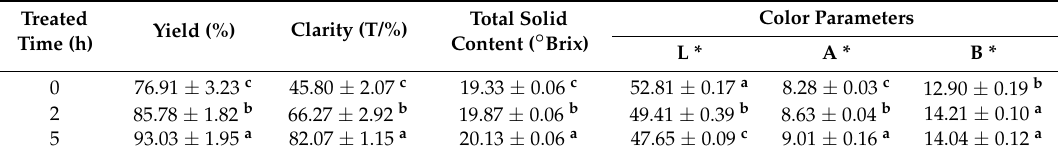
Table 1. Physical properties of longan juice from different enzymatic treatment time